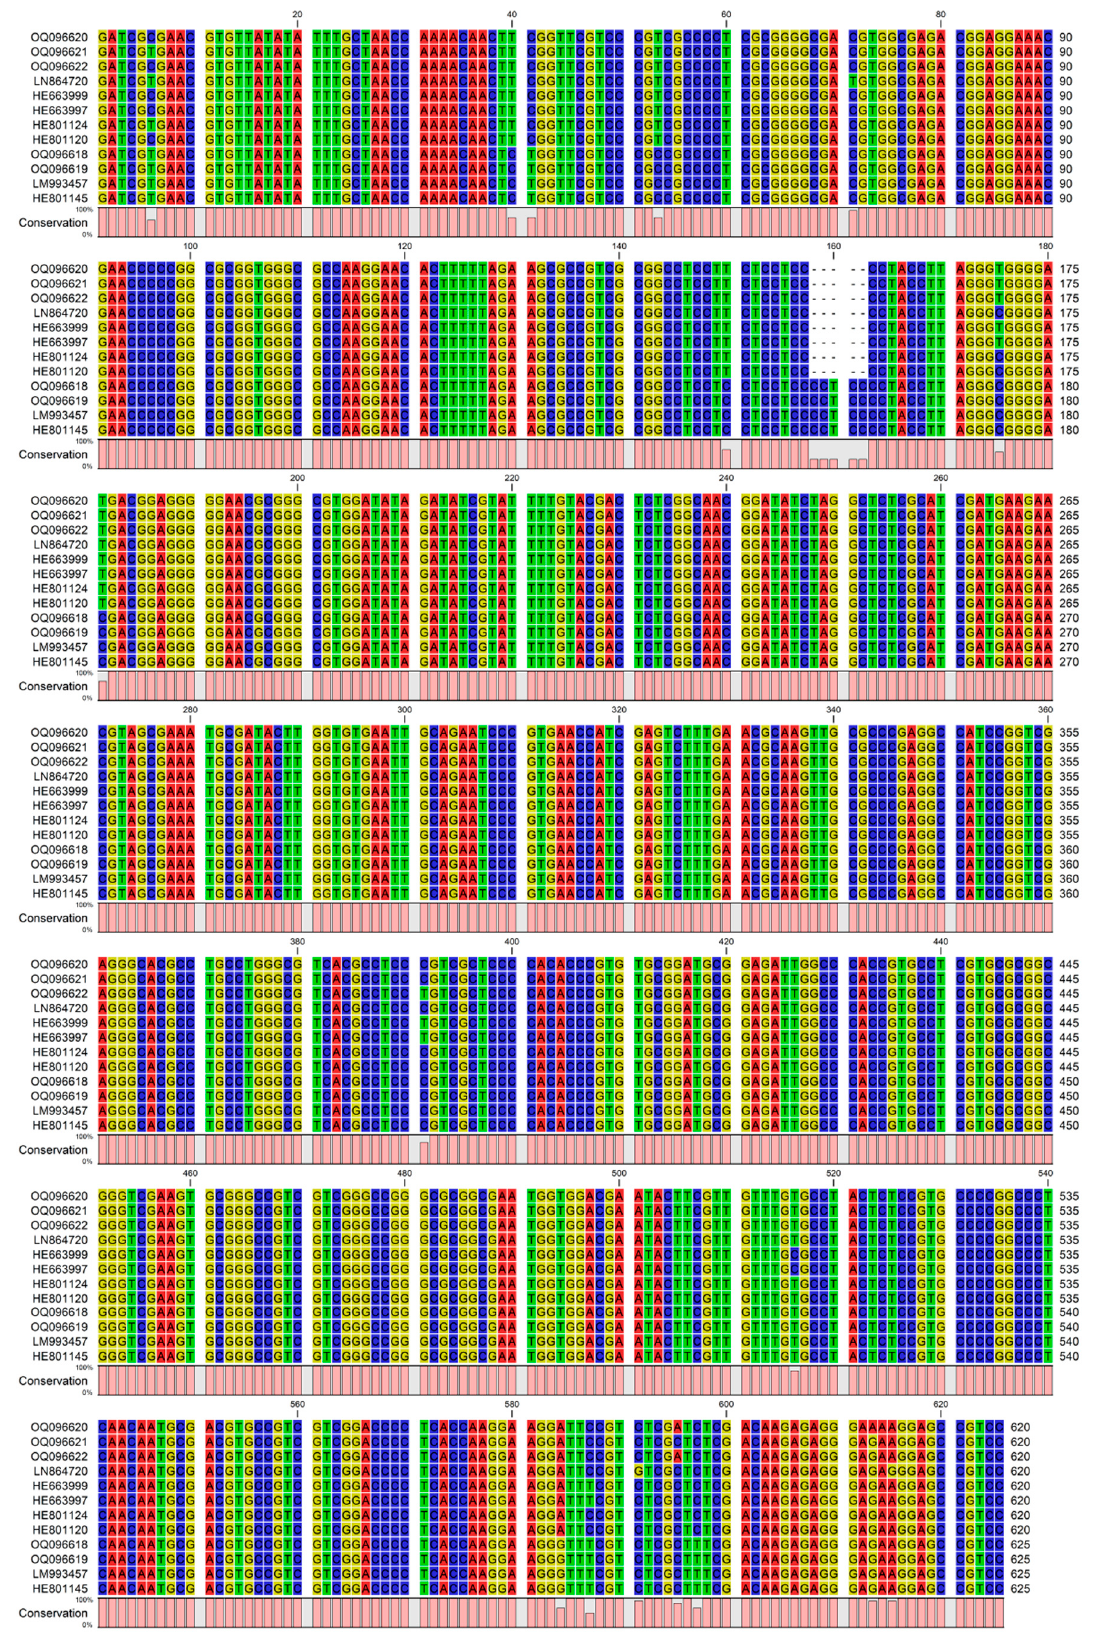
Figure A1. Alignment of the evaluated ITS sequences from C. speciosus and C. pulchellus : visualiza- tion [22].